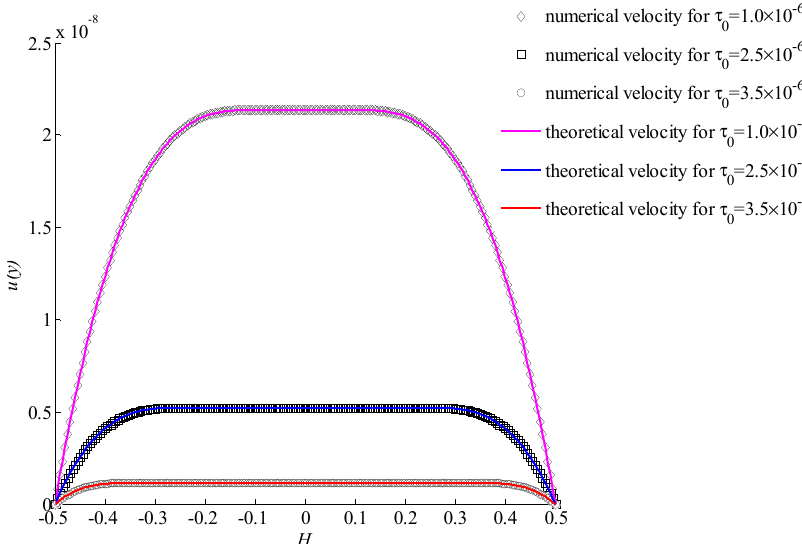
Figure 5. The velocities for n = 0.5 with different initial yielding stresses.